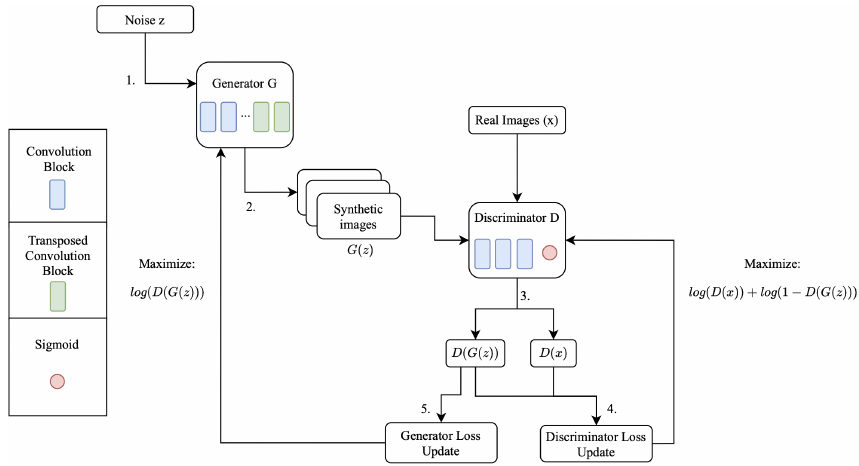
Figure 3. Outline of a GAN